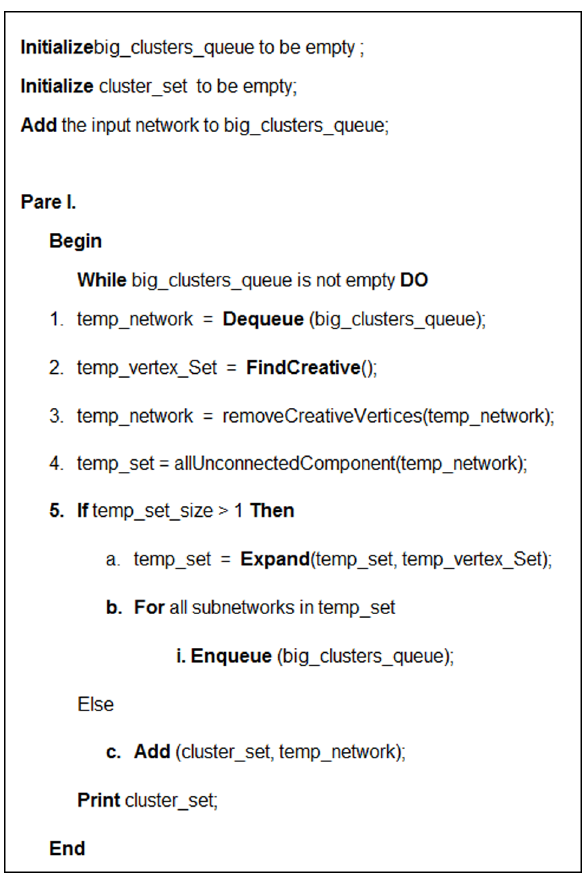
Figure 5. The pseudocode of the first part of the proposed algorithm.